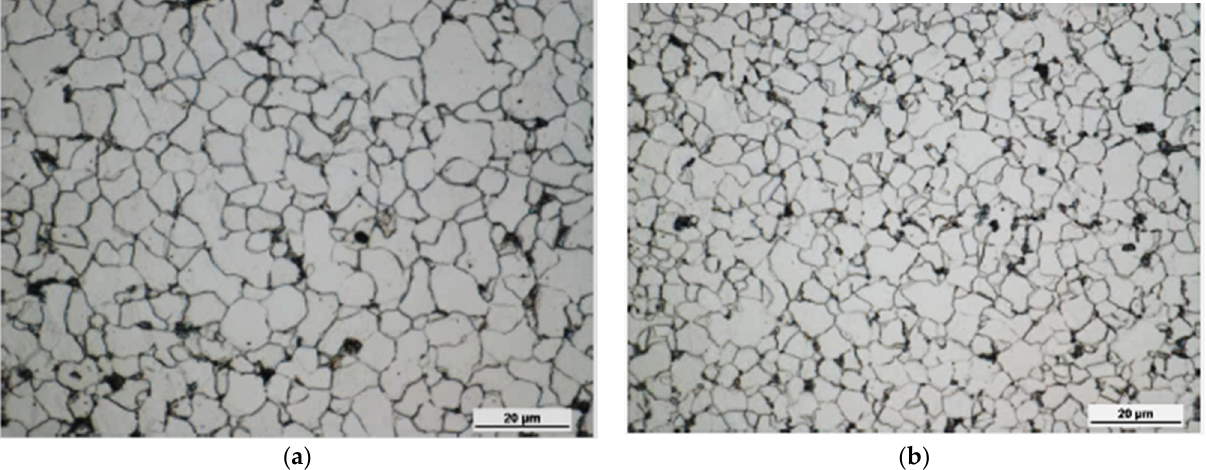
Figure 4. Microstructure of fully recrystallized steels subjected to UFH. ( a ) Low-C 0.08% C, 0.3% Mn steel; ( b ) HSLA 0.07% C, 0.5% Mn, 0.03% Nb steel.